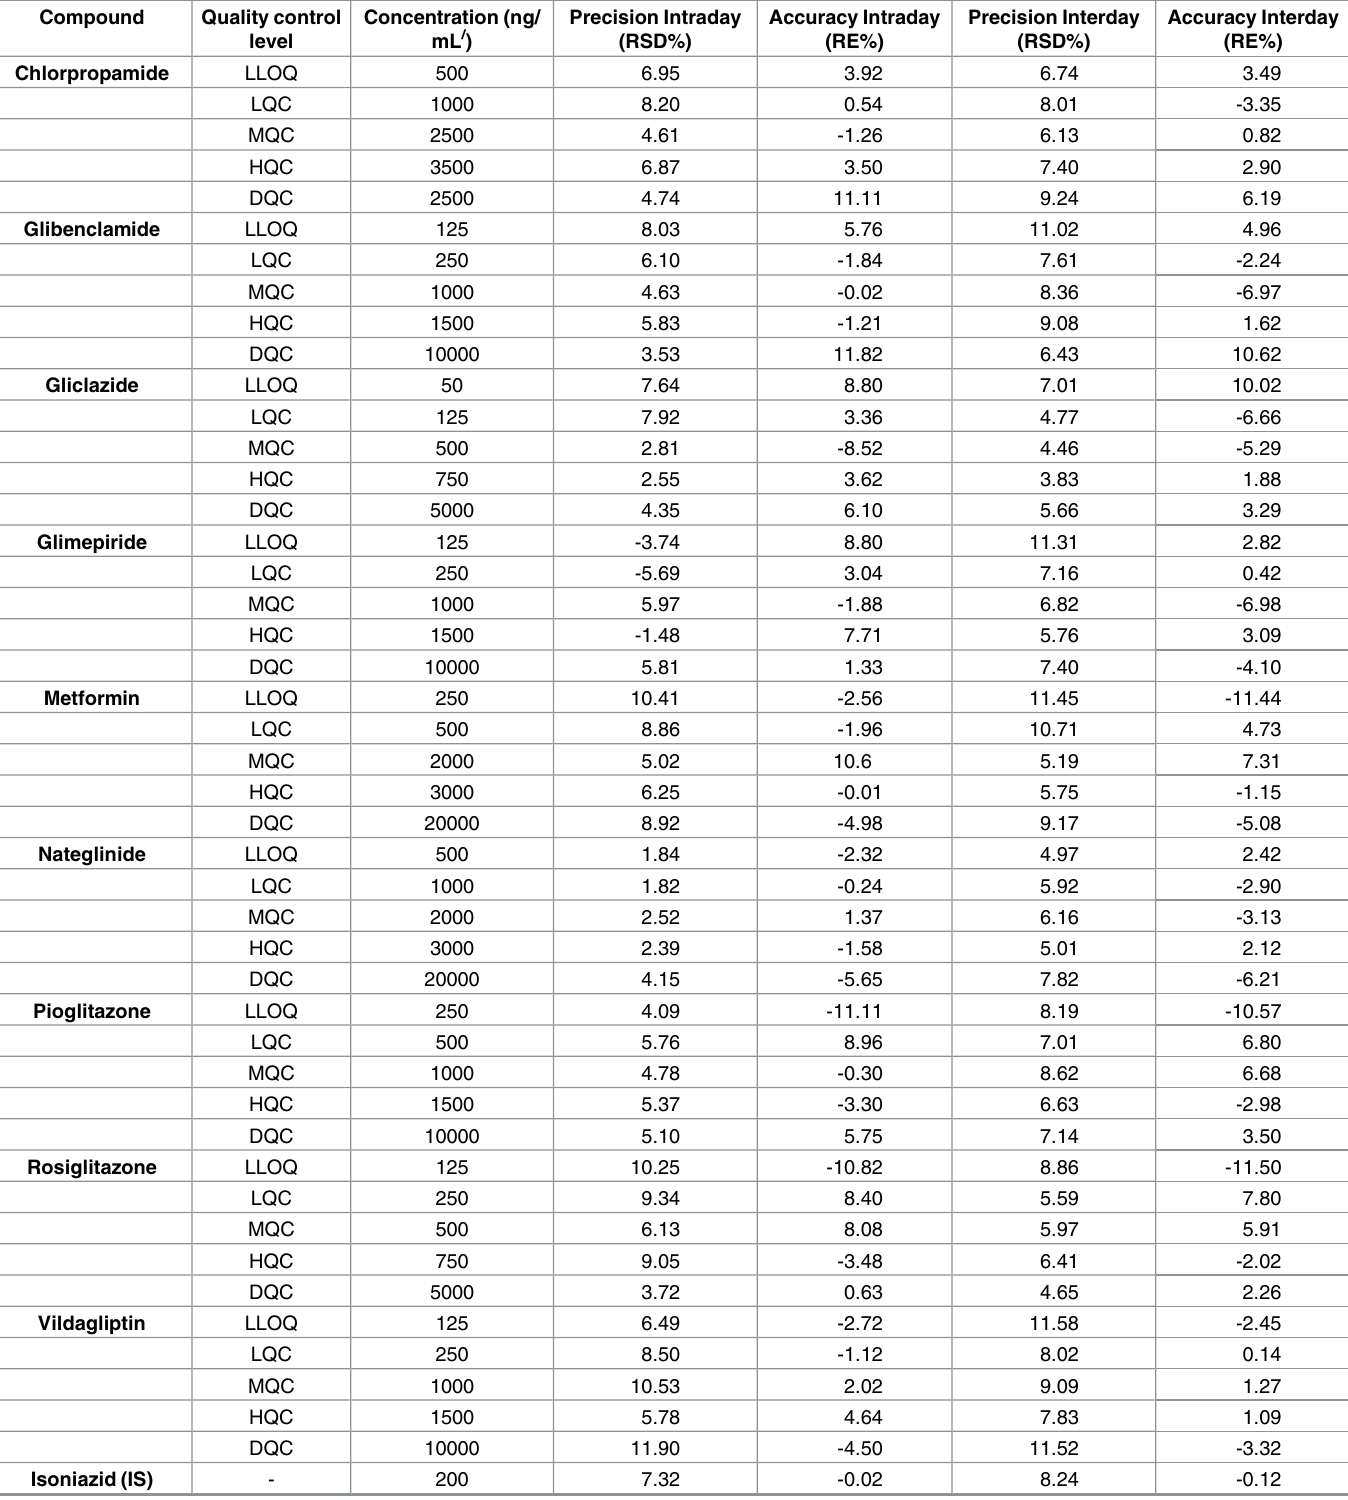
Table 2. Precision and accuracyof the antidiabetic agents and internal standards obtained in human plasma by the UPLC-QToF method.